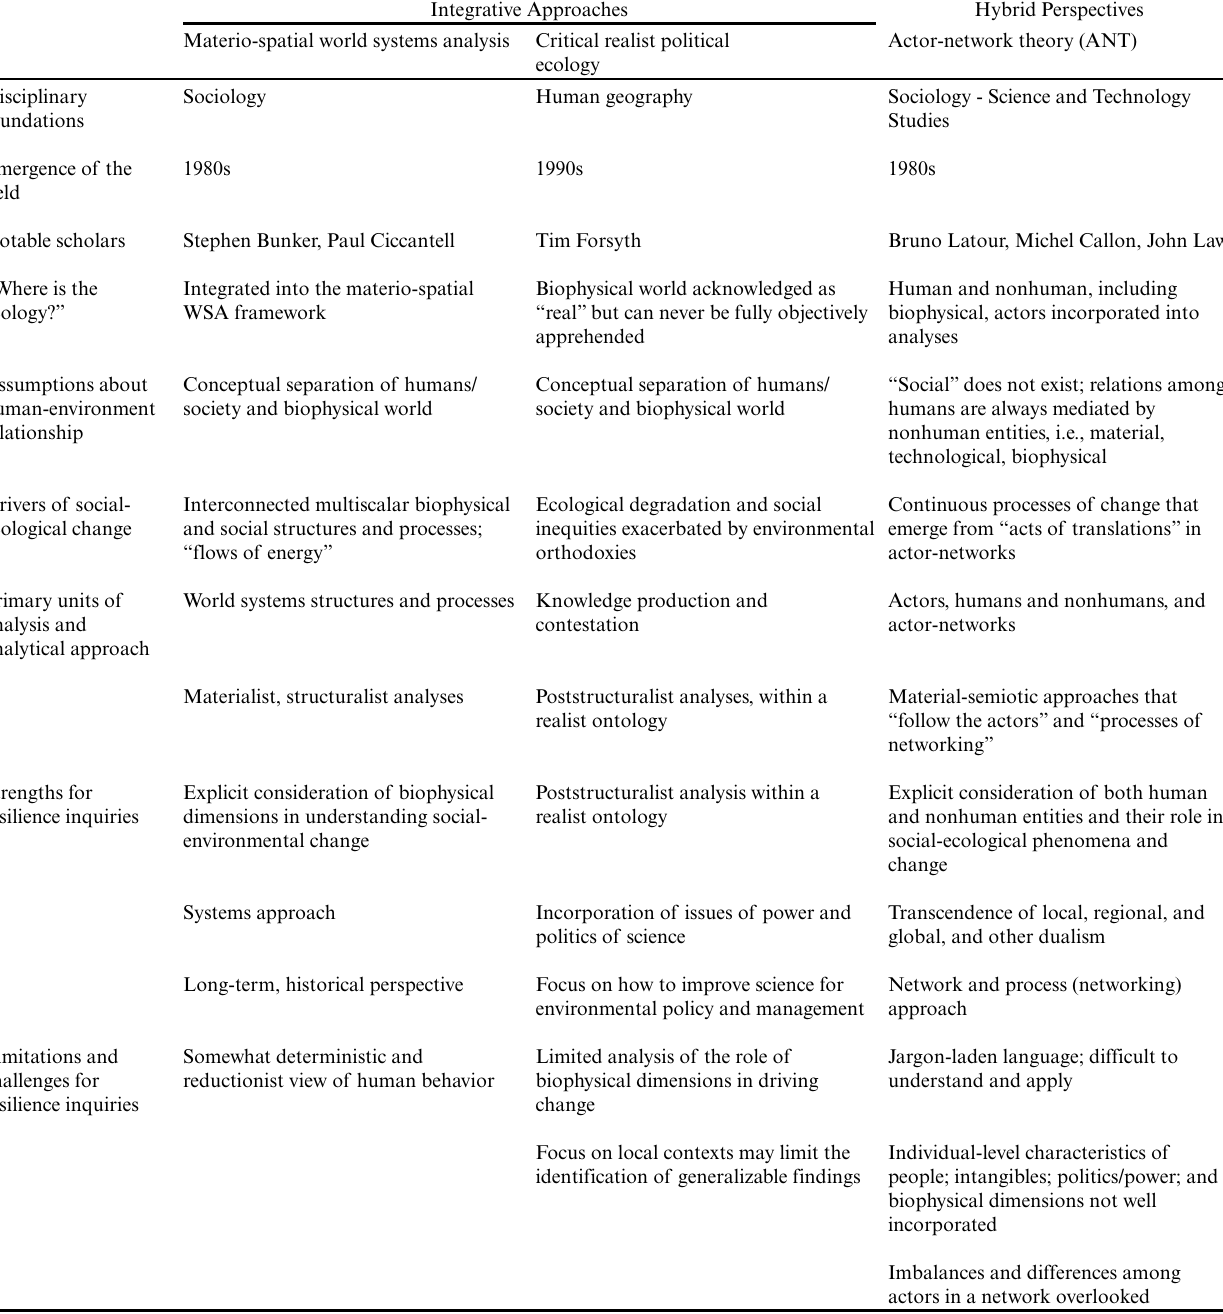
Table 1 . An overview of three bodies of social science scholarship that explicitly incorporate ecological